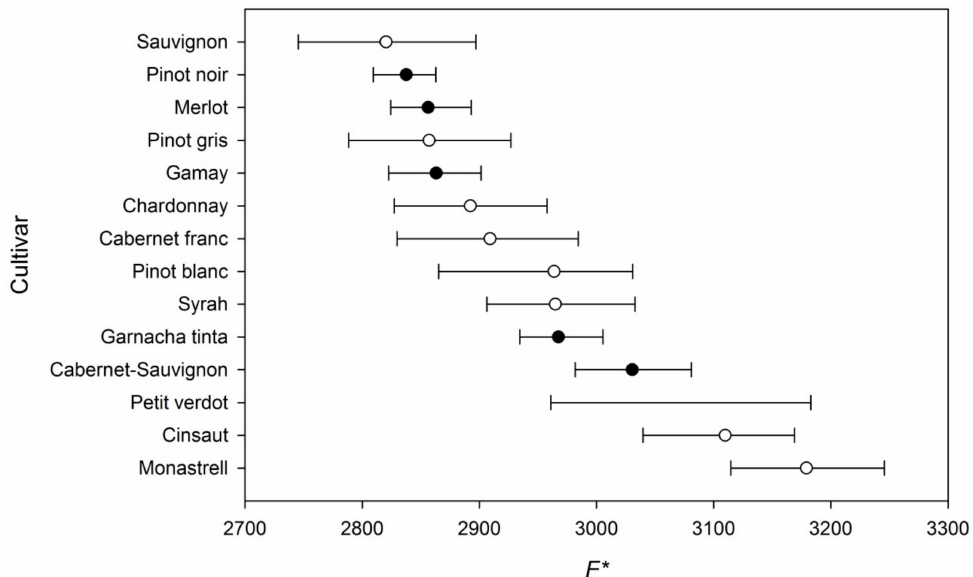
Figure 3. Temperature summation ( F *) to reach 200 g / L of grape sugar according to Grapevine Sugar Ripeness (GSR) model for 15 major grapevine varieties. Horizontal bars represent 95% confidence intervals (CI) which were calculated using the optimization algorithm of Metropolis in PMP v5.4 and determined via the Fisher statistic ( p < 0.05) as in [55]. Closed circles correspond to parameterizations where CI < 100, open circles correspond to CIs in the range 100–200 and no circle corresponds to CIs in the range of 201–350. (Cultivar synonyms: Monstrell = Mourv è dre, Sauvignon = Sauvignon blanc, Garnacha tinta =